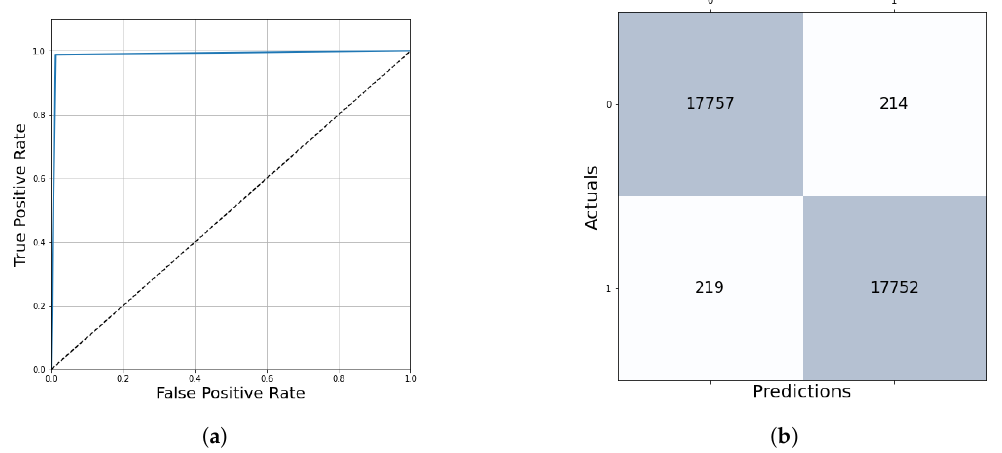
Figure 15. ROC curve and confusion matrix evaluation on the test dataset. ( a ) Averaged ROC curve. ( b ) Confusion